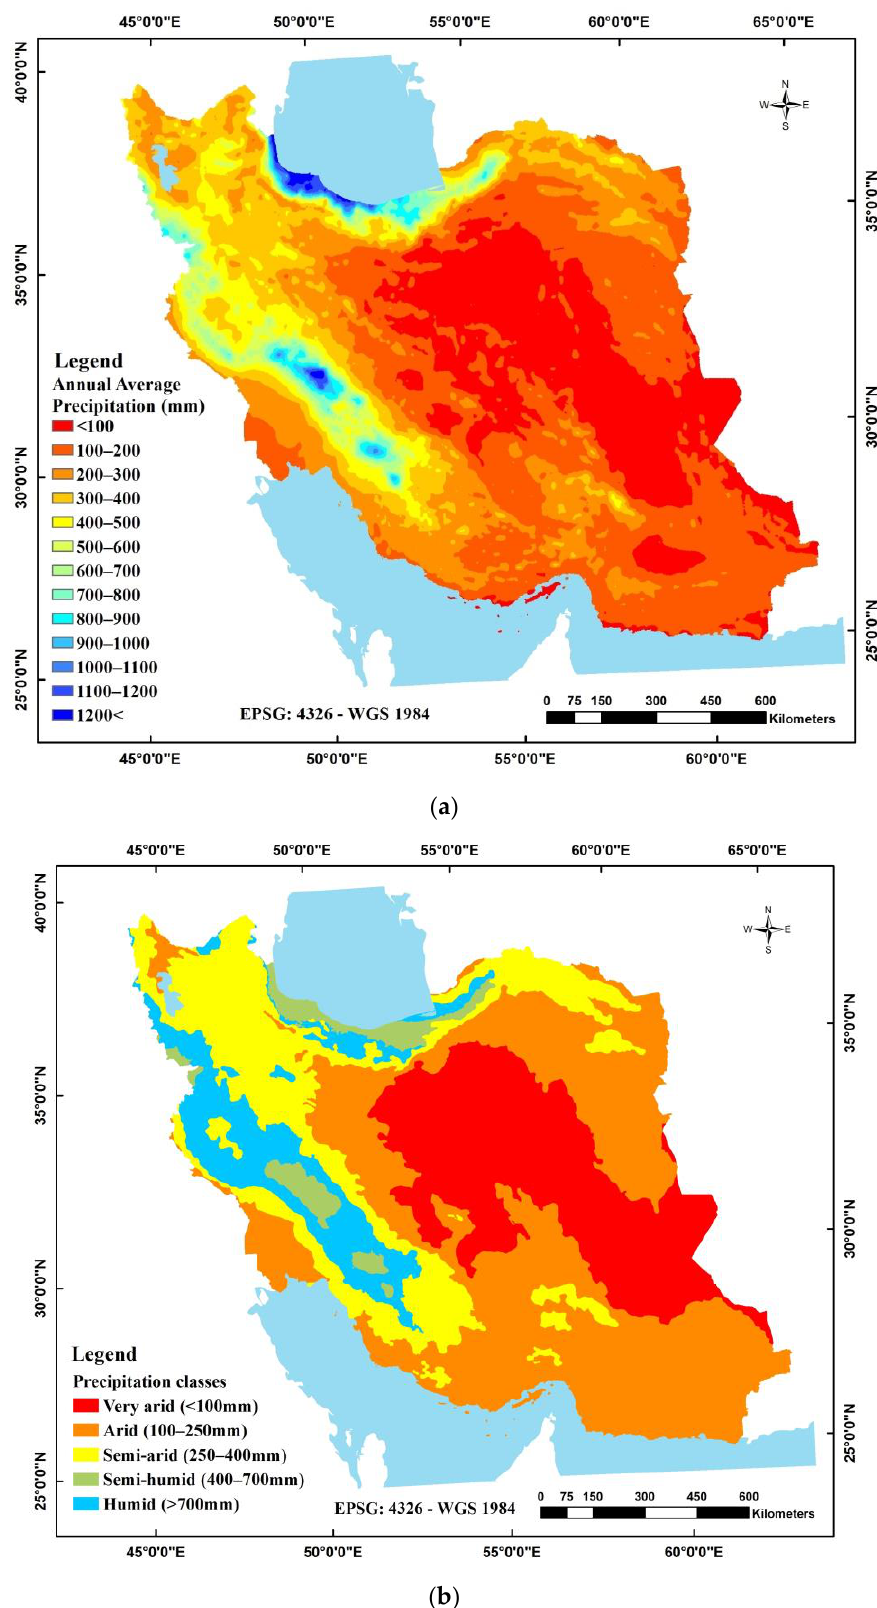
Figure 5. Spatial variability of the annual average precipitation ( a ) and its qualitative classes ( b